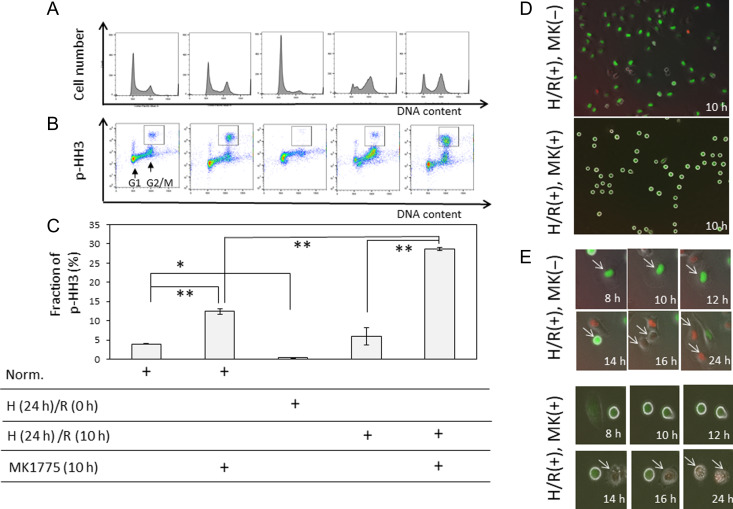
Cell cycle kinetics and time-lapse imaging of Fucci fluorescence after hypoxia/reoxygenation (H/R) alone or H/R followed by WEE1 inhibitor treatment. Flow cytometric analysis of DNA content (Hoechst) (A) and phosphorylated histone H3 (p-HH3) (B). The square represents the p-HH3-positive fraction. (C) Quantitative analysis of pHH3-positive fractions in Fig. 1B. Cells were treated as indicated. Cells were subjected to hypoxic treatment for 24 h and reoxygenated for 10 h in the absence or presence of 300 nM MK1775. In some experiments, cells were treated under normoxic conditions. The cells were then prepared for flow cytometric analysis. Data represent mean values ± SD from three independent experiments. *P < 0.05, **P < 0.01. Norm. = normoxia. Time-lapse imaging of Fucci fluorescence (D, lower magnification; E, higher magnification). Time-lapse images were acquired at the indicated times after reoxygenation in the absence (upper panels) or presence (lower panels) of 300 nM MK1775. The arrows in D (upper panels) indicate G2 arrested cells (green) that later enter the M phase (14 h) and then divide normally into two cells (red cells, 16 and 24 h). Arrows in E indicate cells that died in the M-phase.